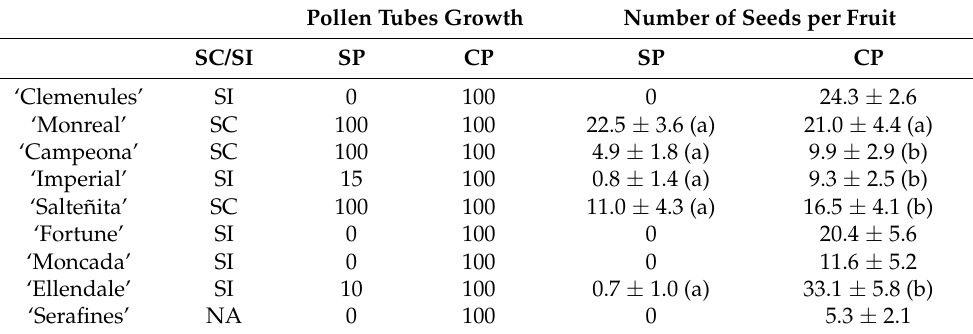
Table 1. Self-compatibility (SC) or self-incompatibility (SI) classification based on pollen tube growth and number of seeds per fruit obtained from hand self-pollination (SP) and hand cross-pollination (CP) treatments in each